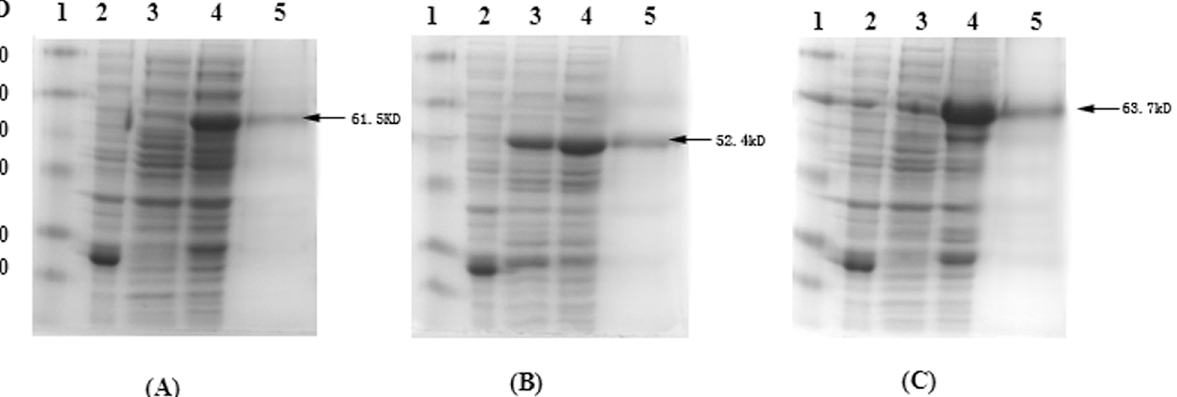
Fig 2. Expression and purification of recombinant proteins. A, B, and C represent roVP1, roVP2, and roVP3 proteins, respectively. SDS-PAGE analysis of roVP1, roVP2, and roVP3 proteins were as follows: Lane 1, low molecular weight protein marker; Lane 2, pGEX-6P-1 vector after induction; Lane 3, wild type gene expression after induction; Lane 4, recoding gene expression after induction; Lane 5, purification of expressed proteins using GST-agarose affinity columns.